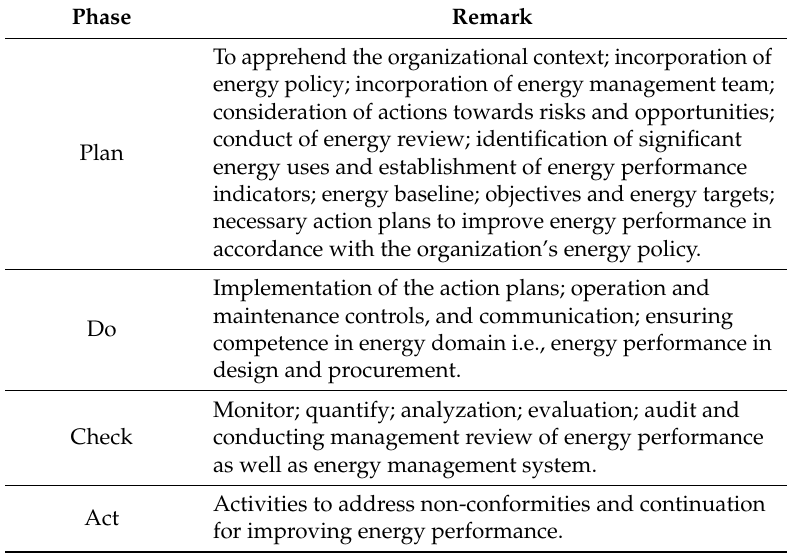
Table 4. The continual phases of ISO 50001 Energy Management System standard